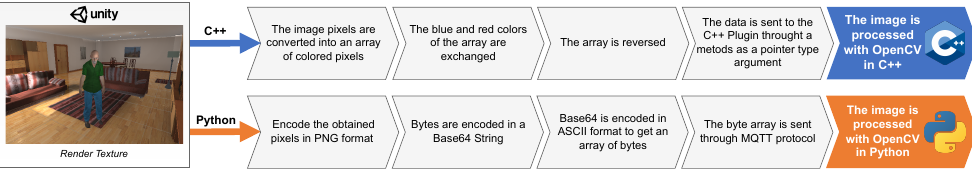
Figure 3. Image conversion and data transmission from Unity to the two approaches evaluated: internal C++ plugin and external Python